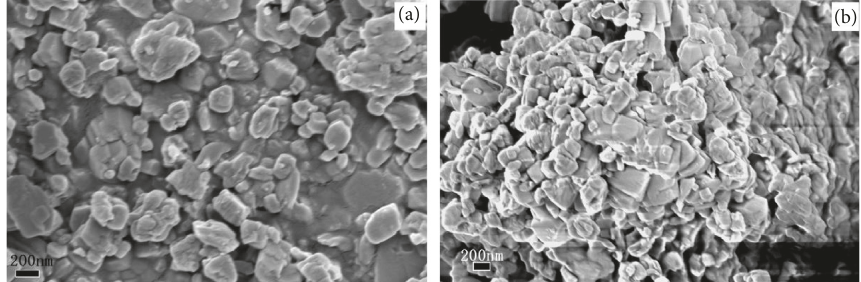
Figure 3: SEM images of MOF-5 and Fe(II)/MOF-5 (3% Fe 2+ ). Table 1: Element content of Fe(II)/MOF-5 (3% Fe 2+ ). Element